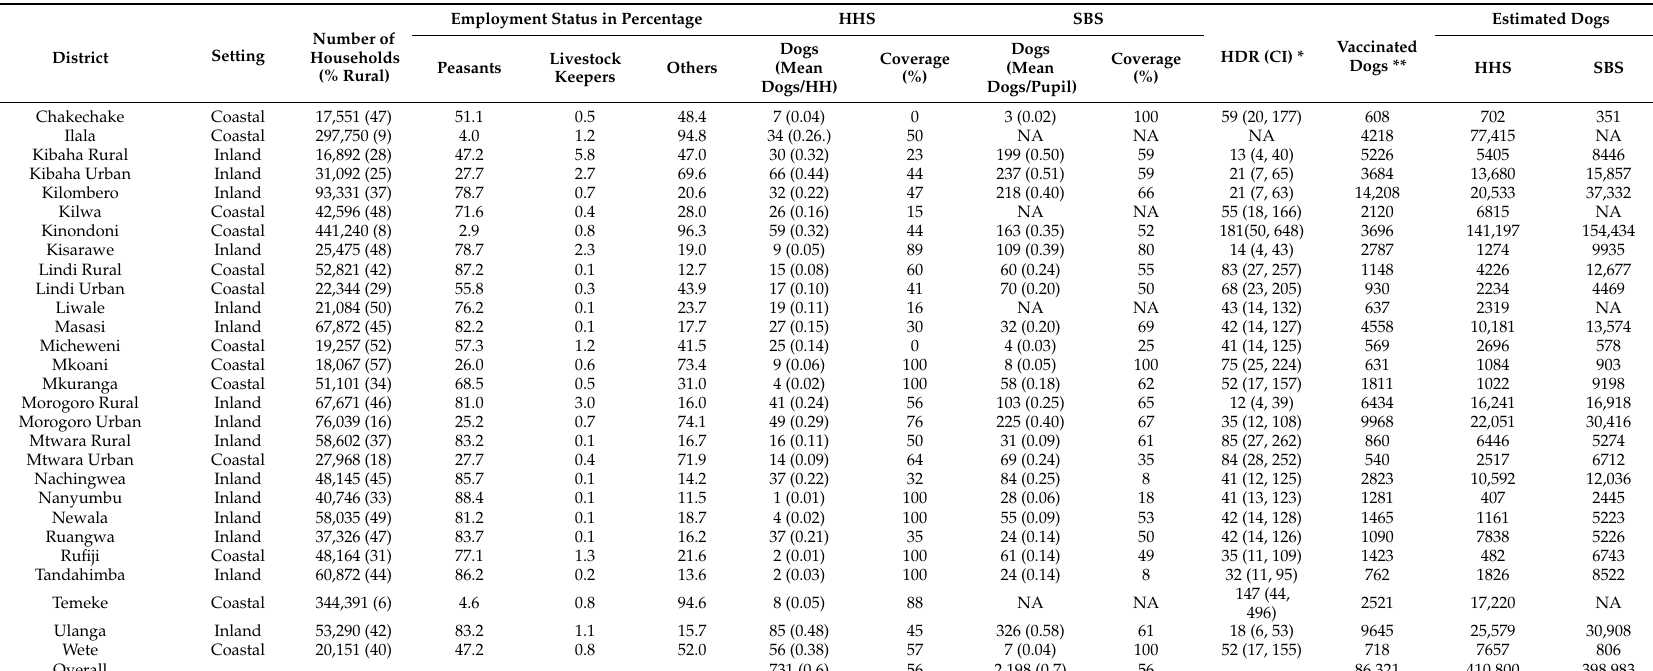
Table A2. Descriptive characteristics of the study districts. Number of households and employment status were obtained from the 2012 national census [16]. In household surveys, ~30 households/village were sampled in 6 (range 2–6) villages/district (ranged 93–180 households) per district ([13], Table 2). For school-based surveys, ~100 pupils were sampled per school in 6 (range 3–6) schools/district, whereby questionnaires were administered to 152–645 pupils per district. Dogs counted during surveys, mean dogs per household and vaccination coverage were compiled or calculated from household or school-based surveys. Human/dog ratios (HDRs) were calculated from transects and numbers of vaccinated dogs were compiled from mass dog vaccination campaigns, both conducted in 2014–2015. HHS = household survey. SBS = school-based survey. CI = confidence interval. NA = not